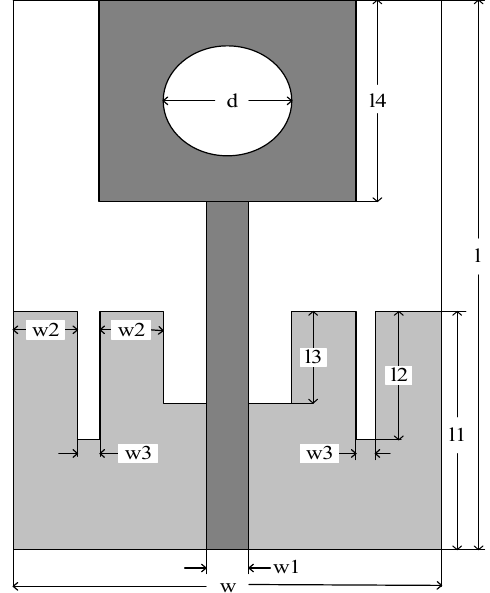
Figure 8. The initial geometry of planar miniaturized multiband antenna.